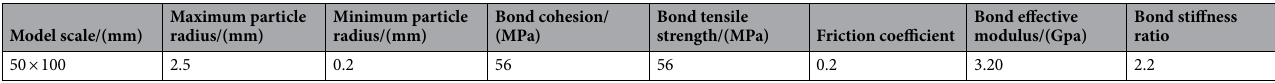
Table 1. Microscopic parameters of the model.